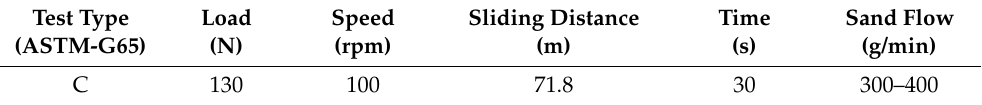
Table 4. Tests parameters for the wear assays according to ASTM-G65 standard [14]. Test